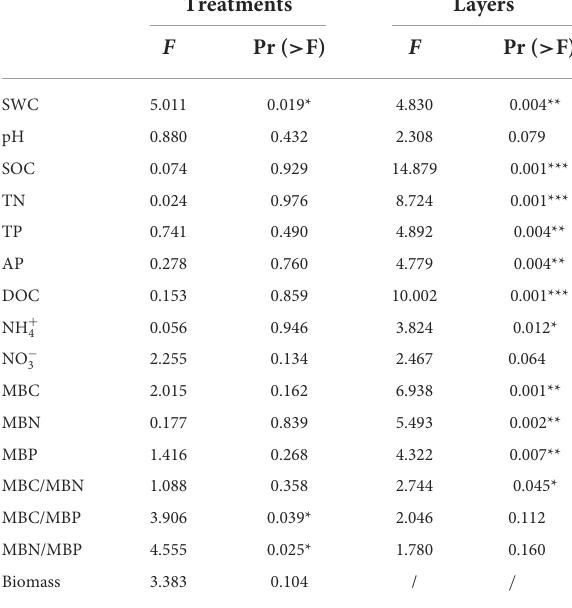
TABLE 1 Results of two-way nested ANOVAs for the effects of treatment and soil depth (nested within treatments) on soil characters and the results of one-way ANOVA for plant biomass affected by the